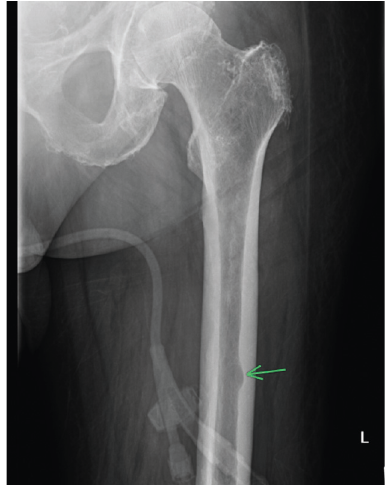
Figure 3: Lytic lesions on the skull. Figure 4: Lytic lesions on the L